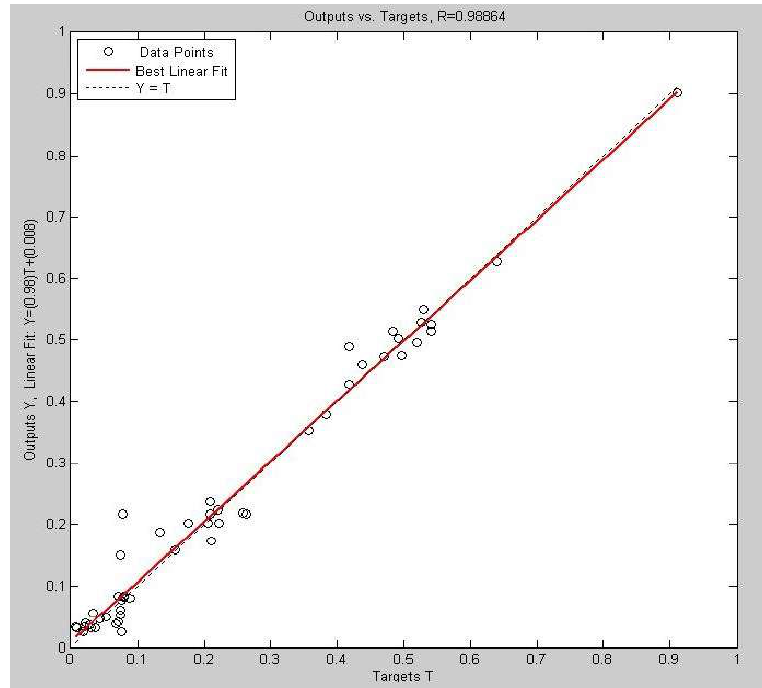
J. Mar. Sci. Eng. 2018 , 6 , x Figure 8. Thrust neural network regression. analysis (outputs vs targets). Figure 8. Thrust neural network regression. analysis (outputs vs. targets).